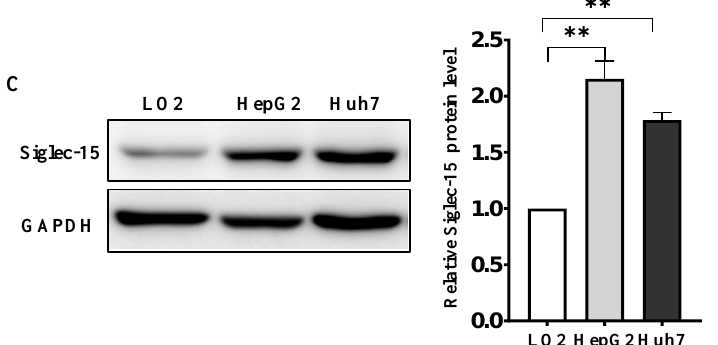
Figure 1. Expression of Siglec-15 in HCC tumors compared to adjacent normal tissues. ( A ) Siglec- 15 mRNA expression in HCC and adjacent normal tissues of patients from TCGA database. The data were analyzed by a statistical programming language, Bioconductor, with the test method of Wilcoxon. p = 0.006. ( B , C ) The mRNA ( B ) and protein ( C ) expression levels of Siglec-15 in the normal embryonic liver cell LO2 and HCC cell lines HepG2 and Huh7 examined by quantitative real-time PCR and Western blot analysis (n = 3; ** p <